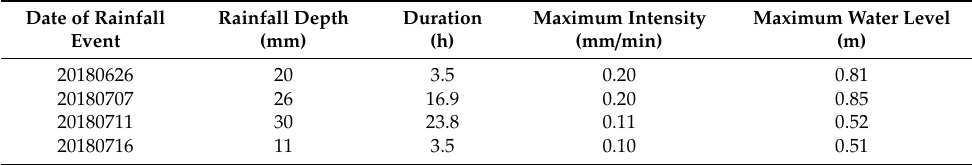
Table 1. Rainfall event information selected by model parameter